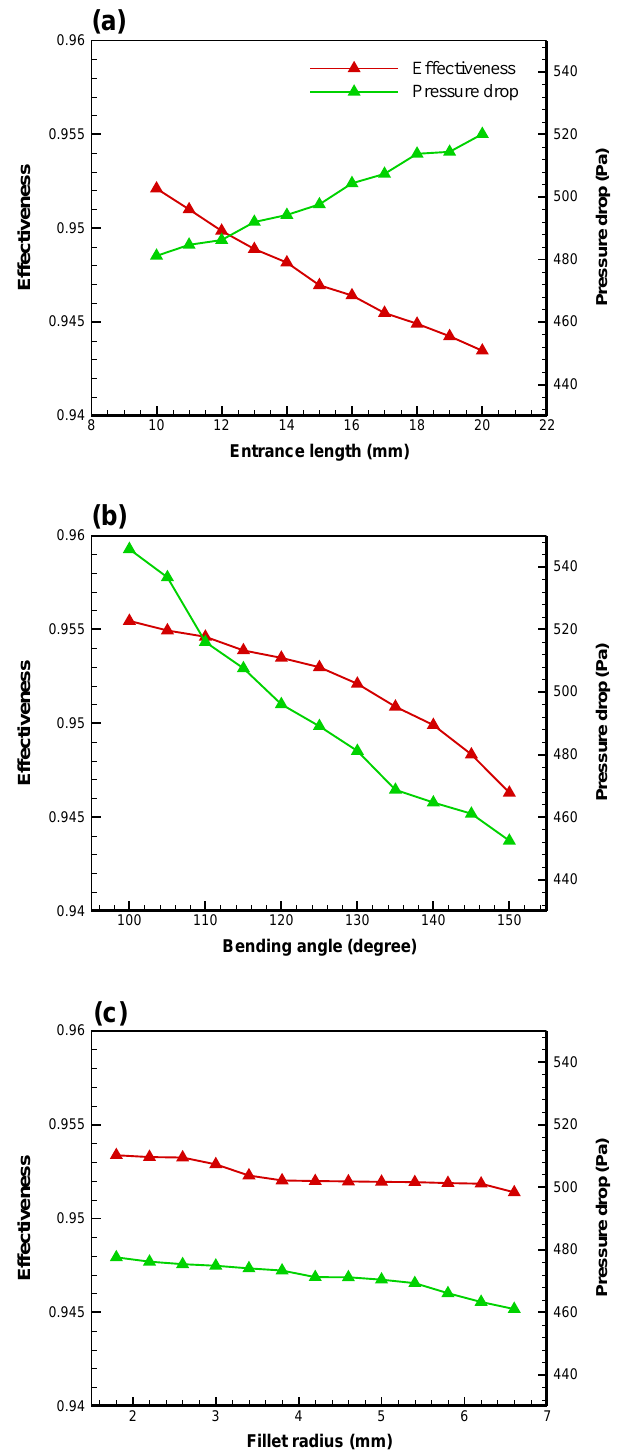
Fillet radius (mm) Figure 11. Effects of ( a ) the entrance length, ( b ) the bending angle, and ( c ) the fillet radius on the effectiveness and pressure drop of the PHE.